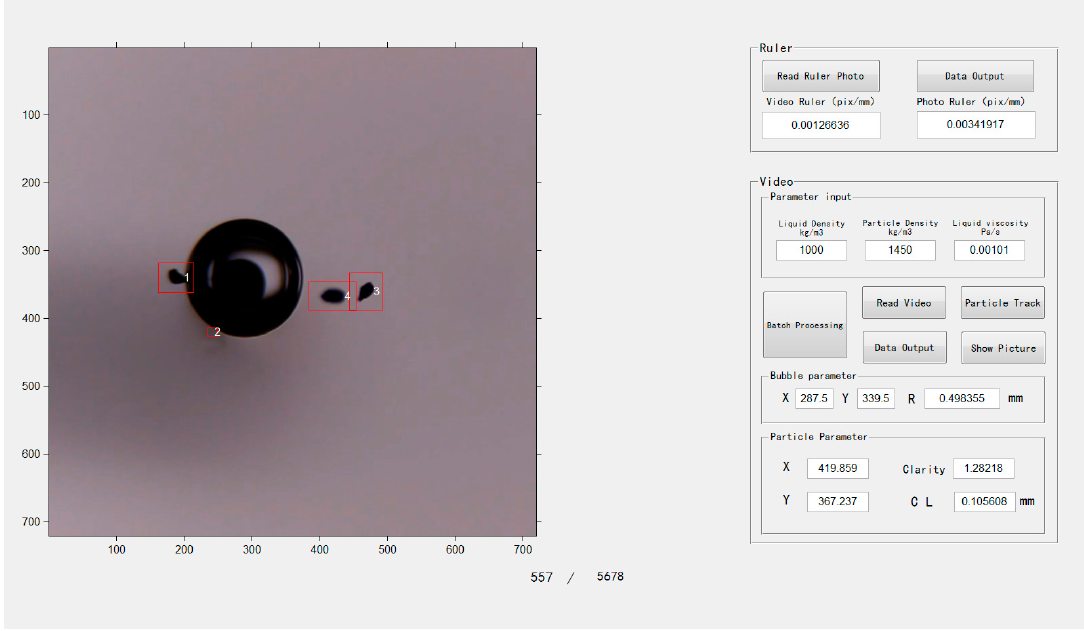
Figure 3. Diagram of software.